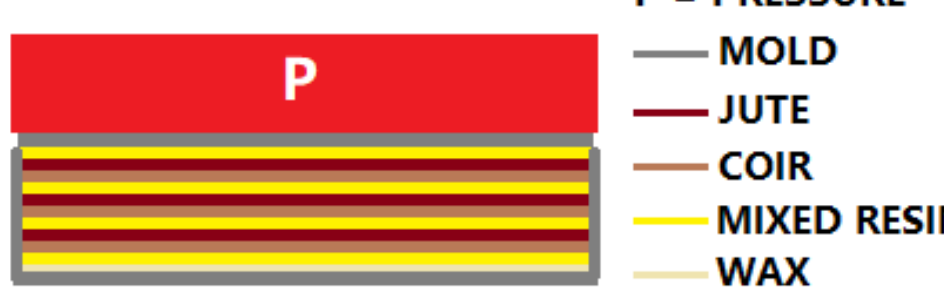
Figure 1. Scheme of the laminates lay-up before pressure consolidation. The fabricated composites were taken out from the mold and cut into the recom- mended dimension required in ASTM G99-17 standard for tribological testing. The test was carried out by a pin-on-disc wear tester. Figure 2 shows the experimental setup for a pin-on-disc wear tester (Make: Magnum Engineers, Bangalore), using a 5 mm pin on a 55 × 10 mm disc.